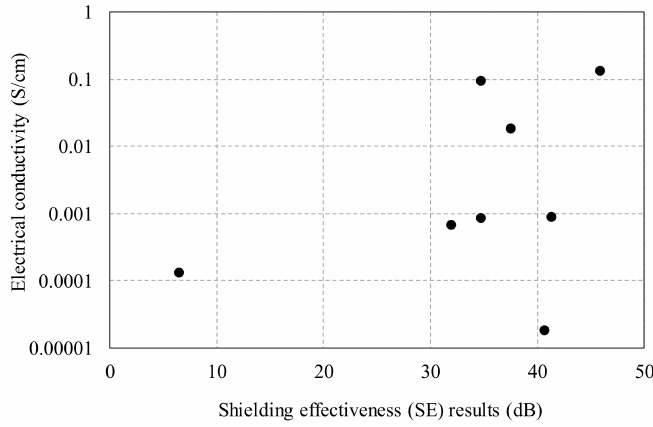
Figure 16. Electromagnetic shielding e ff ectiveness versus electrical conductivity of